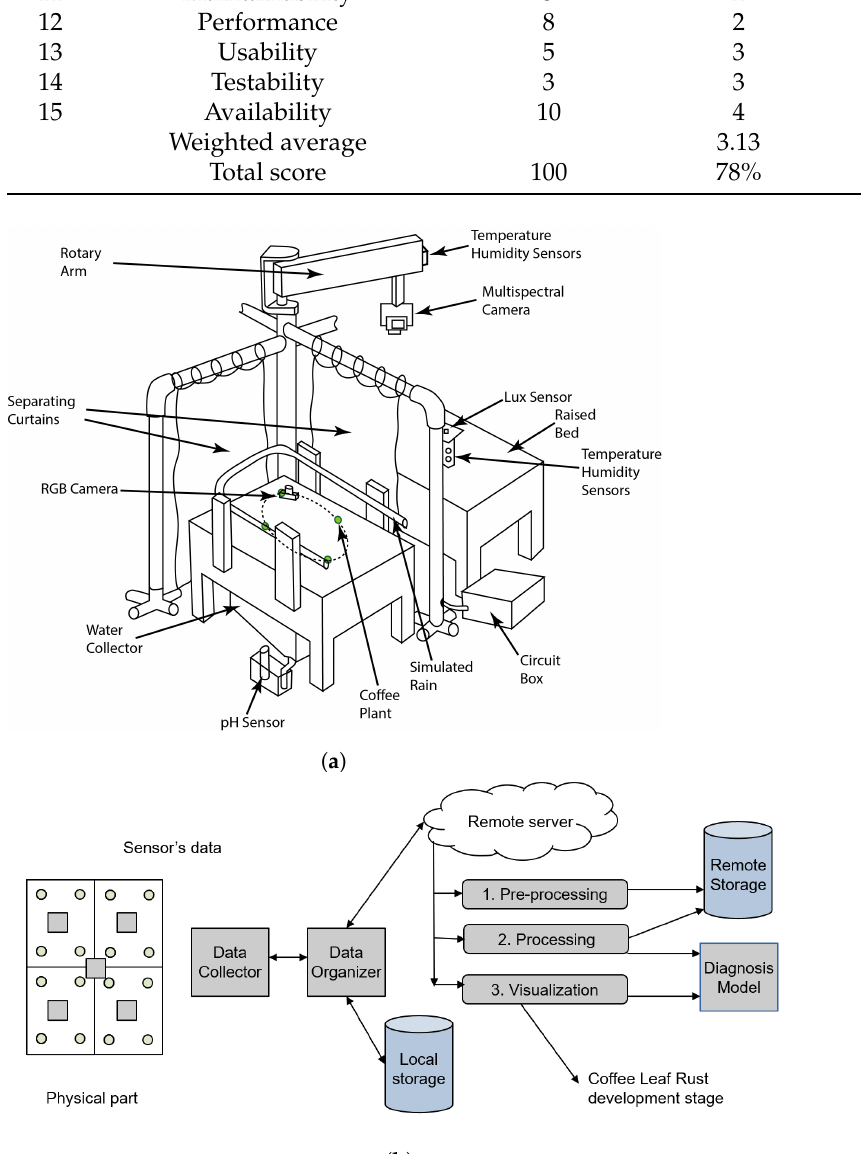
Figure 2. Final concept sketch for the data collection system: ( a ) of the physical part; ( b ) of the cybernetic